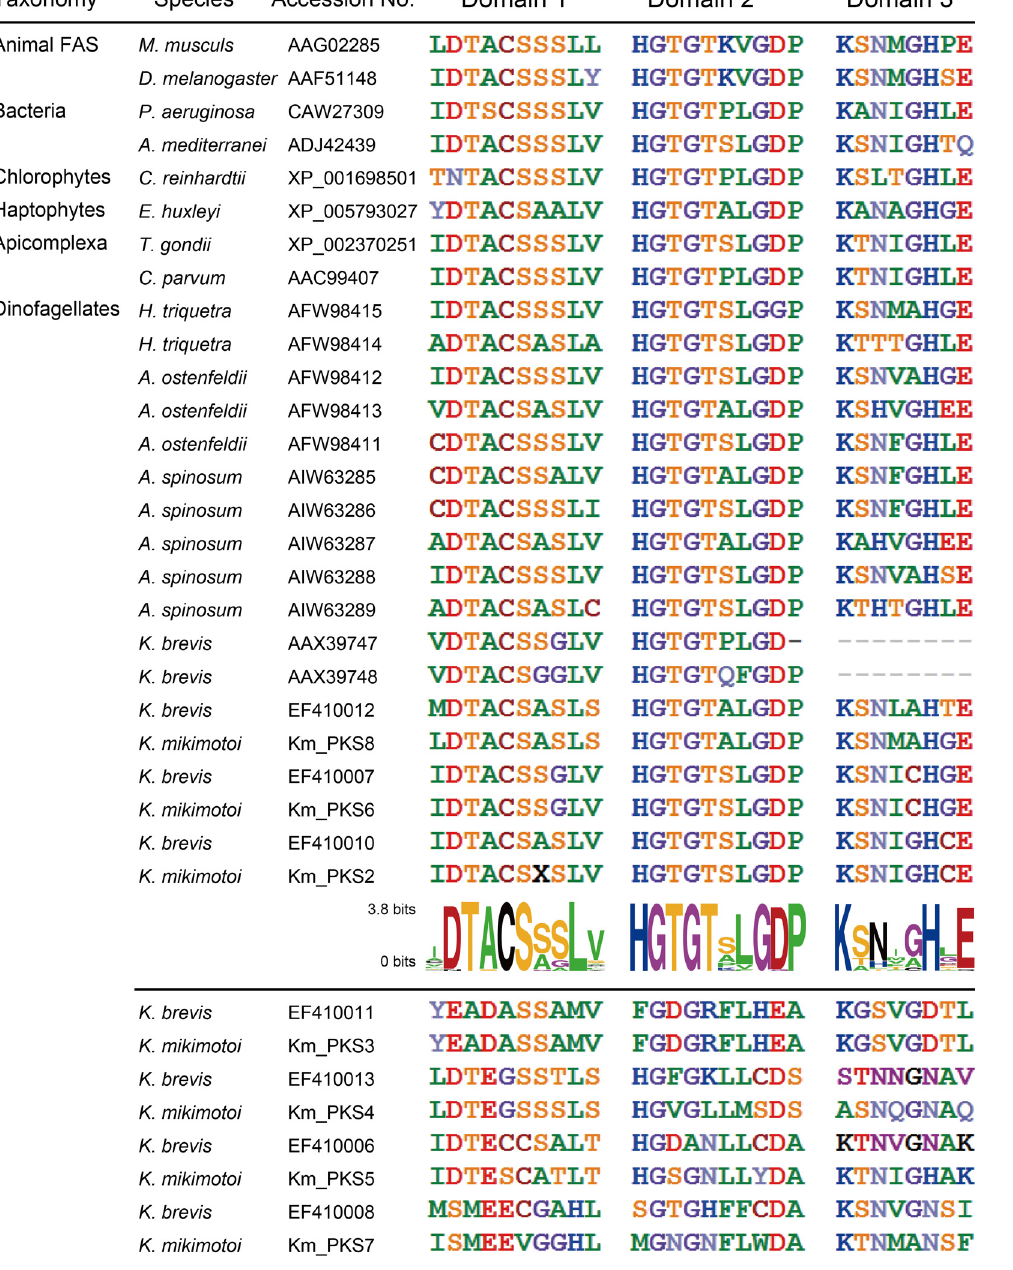
Fig 3. Comparison of amino acid sequences of KS active site in various PKSs. This analysis focused on three KS domains of dinoflagellate, Apicomplexa, Haptophytes, and others. The sequence logos provided the conservation of each amino acid sequence against PKSs mentioned above the middle